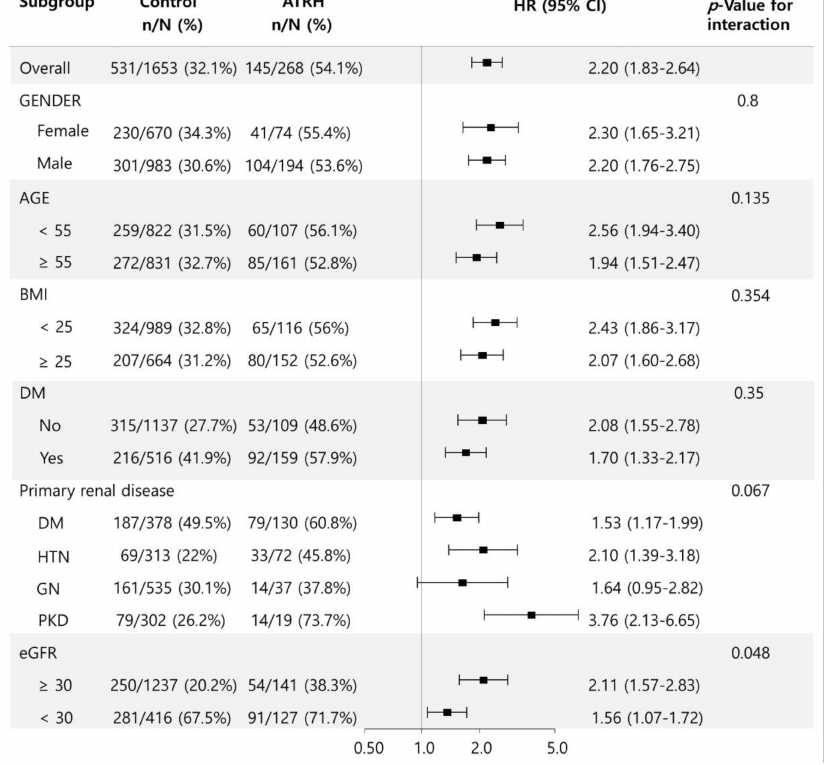
Figure 3. Subgroup analysis for the association between ATRH and end-point renal outcome according to sex, age, BMI, presence of DM, primary renal disease, and eGFR. Abbreviations: ATRH, apparent treatment-resistant hypertension; BMI, body mass index; DM, diabetes mellitus; eGFR, estimated glomerular filtration